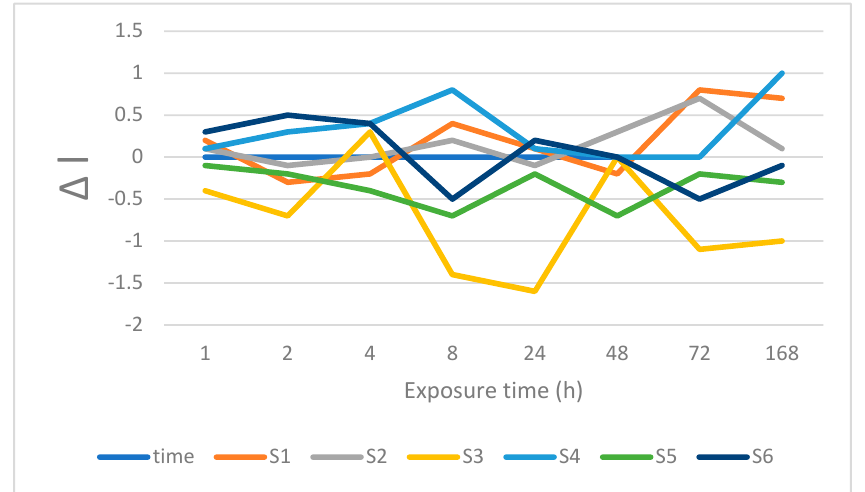
Figure 2. Changes is lightness after immersion in water.